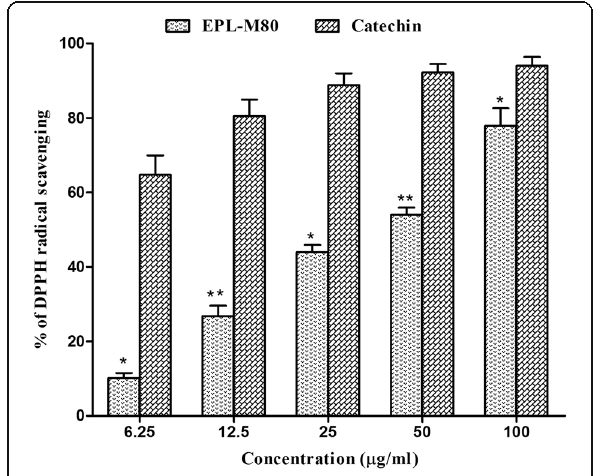
Fig. 3 DPPH radical scavenging activity at different concentrations of EPL-M80 and the reference standard catechin. Results are presented as mean ± SEM ( n = 3). * p < 0.05 and ** p < 0.01 denotes significant difference compared to the control